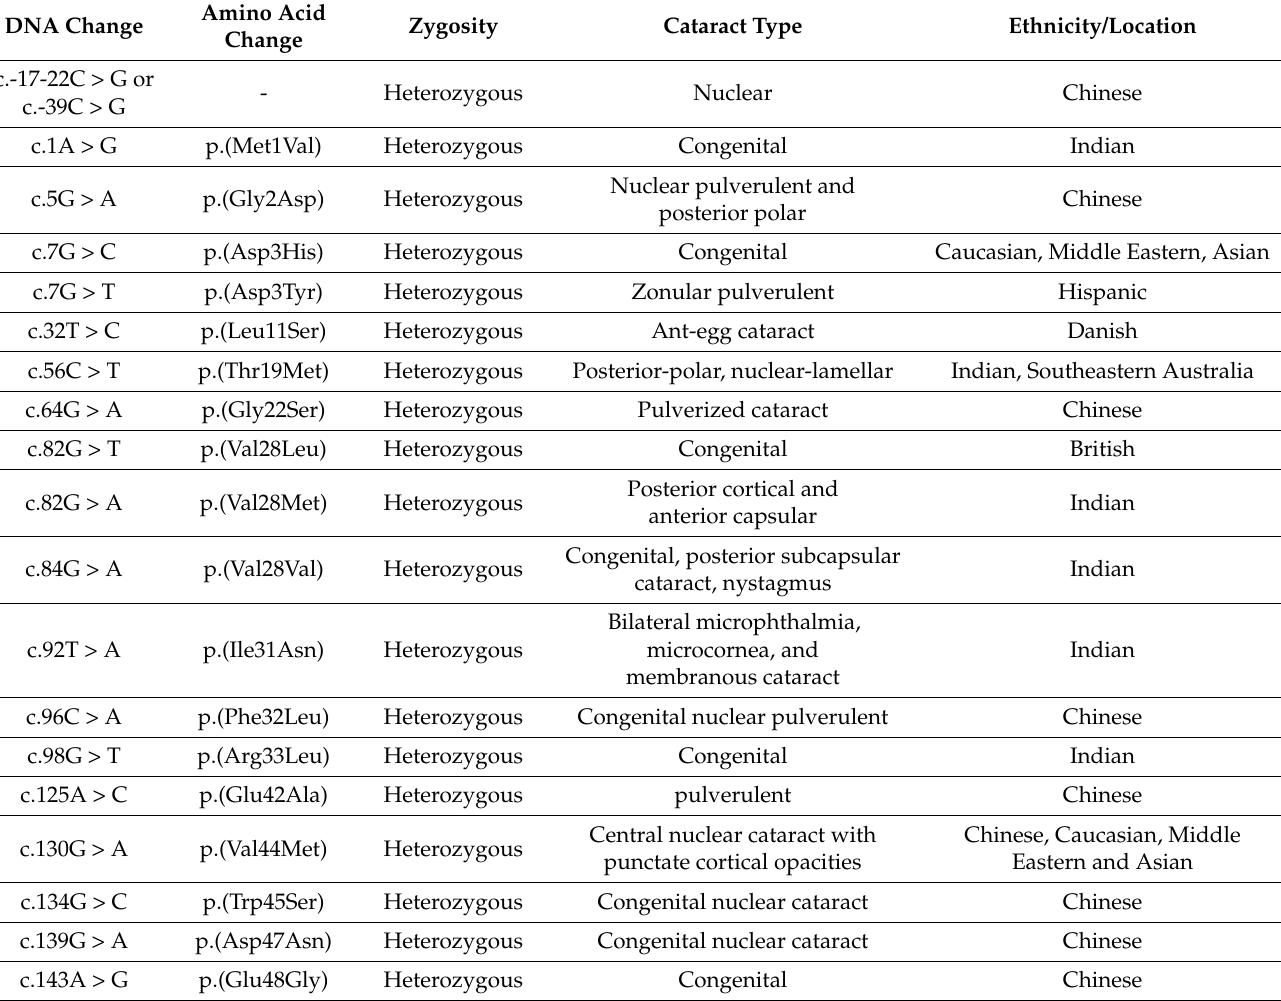
Table 1. GJA3 variants, inheritance, cataract type, ethnicity or origin, and ACMG